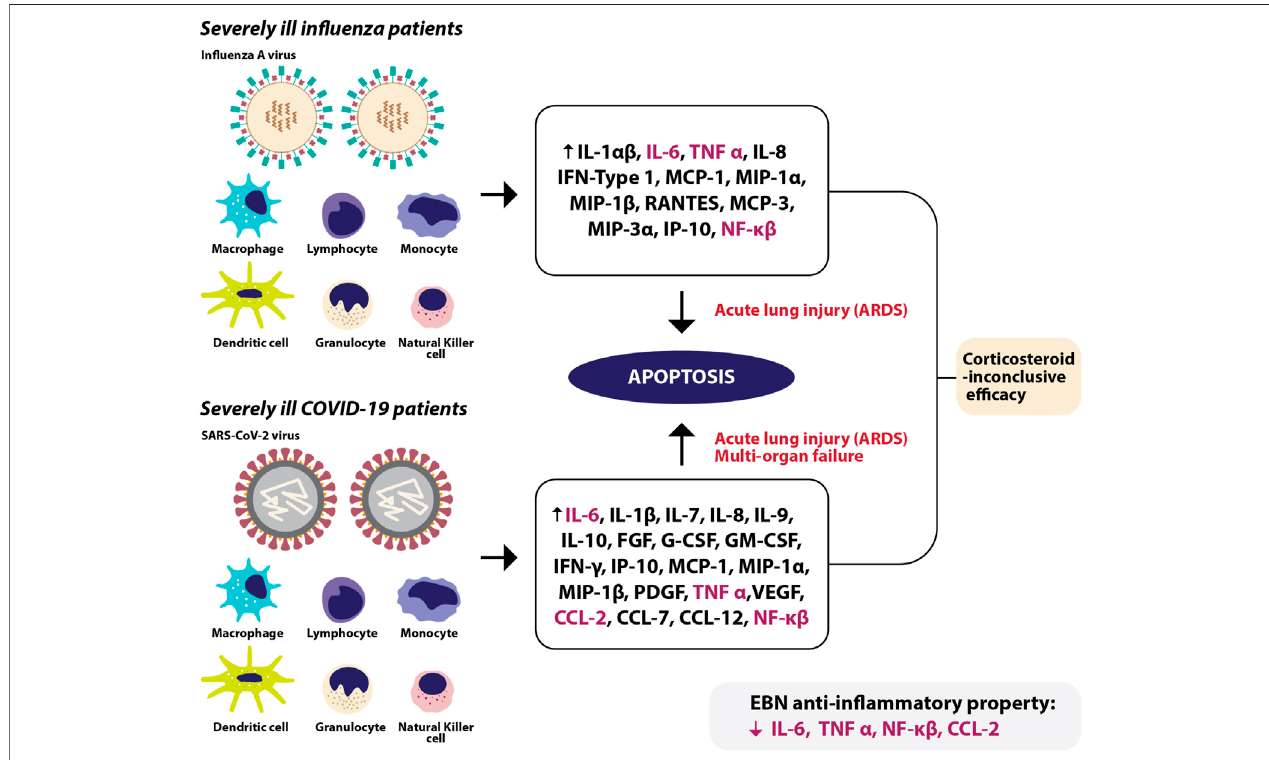
FIGURE2| Inseverelyillin fl uenzapatients,immunecellsreleasevarious cytokinesandchemokinesleadingtoacutelunginjury,oralsoknownasacuterespiratory distress syndrome (ARDS) due to apoptosis. In severely ill COVID-19 patients, various immune cells release a myriad of chemokines and cytokines causing apoptosis, leading to ARDS and spillover of cytokines and chemokines into the blood circulation causing multi-organ failure. Among the escalated cytokines and chemokines in severe in fl uenza and COVID-19 infections, EBN was shown to reduce IL-6, TNF- α , CCL-2, and NF- κβ at the pre-clinical level.